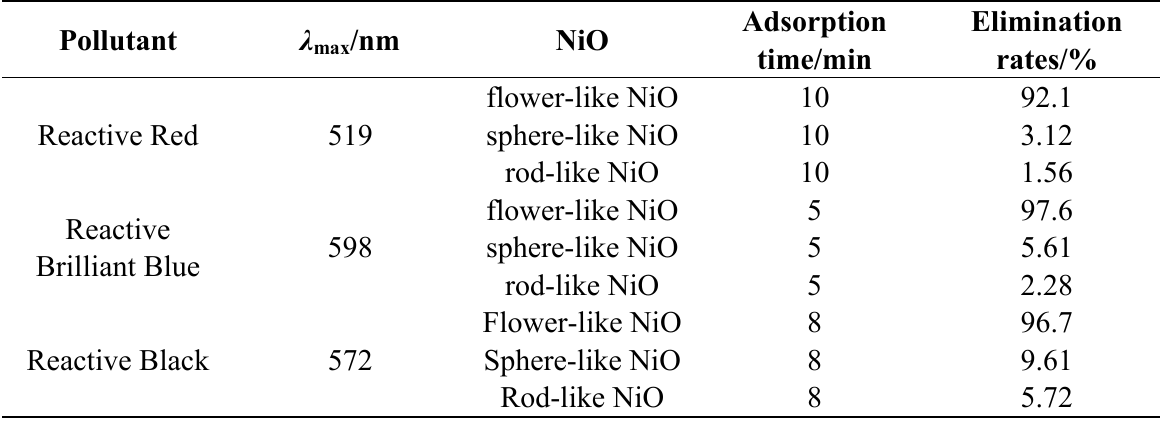
Table 1. Elimination rates of various pollutions in the presence of flower-like, sphere-like and rod-like NiO